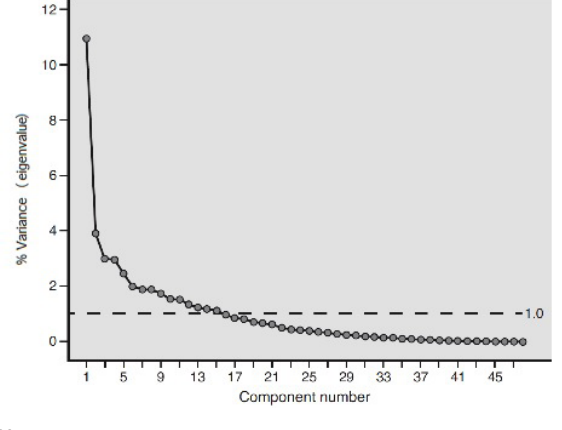
Figure 1. Factor analysis of the 48-item draft QOL-E© instrument in the pilot (derivation) study (n=52